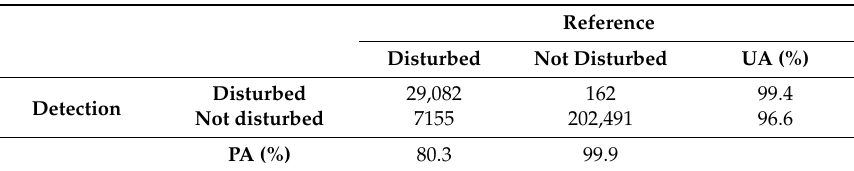
Table 2. Confusion matrix of S1-based approach.